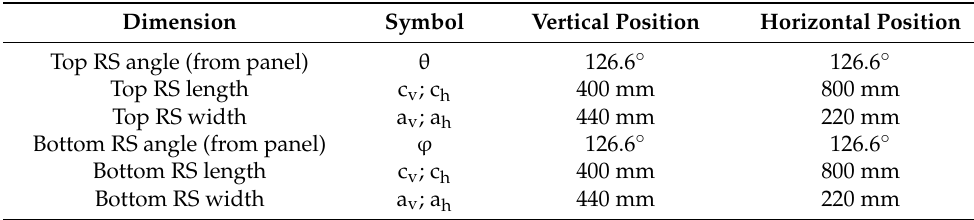
Table 3. GeoGebra results. Geometry of reflective